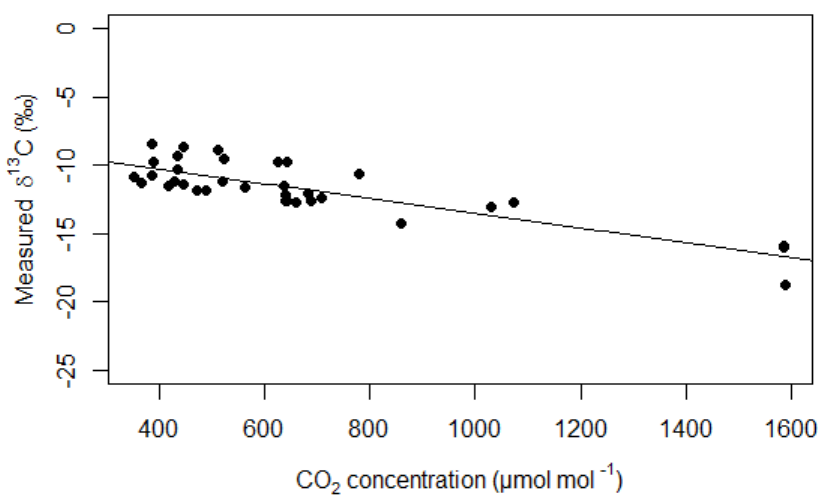
Figure 3. Effect of the CO 2 concentration dependence on measured δ 13 C determined by the QLC. The points show the measurements of the samples with different CO 2 concentrations that were made by mixing a gas of known δ 13 C with CO 2 free synthetic air and the line shows the fitted linear regression from which equation (4) was derived.